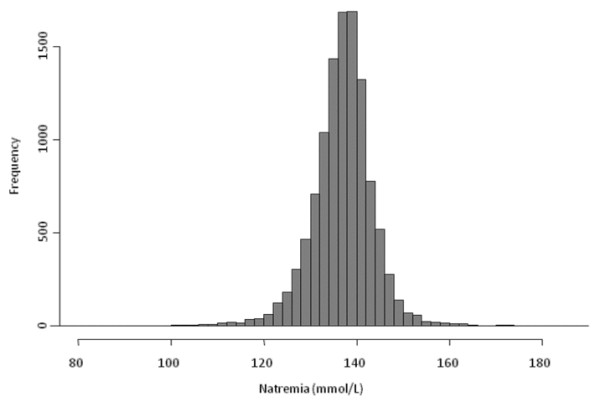
Natremia distribution at ICU admission.